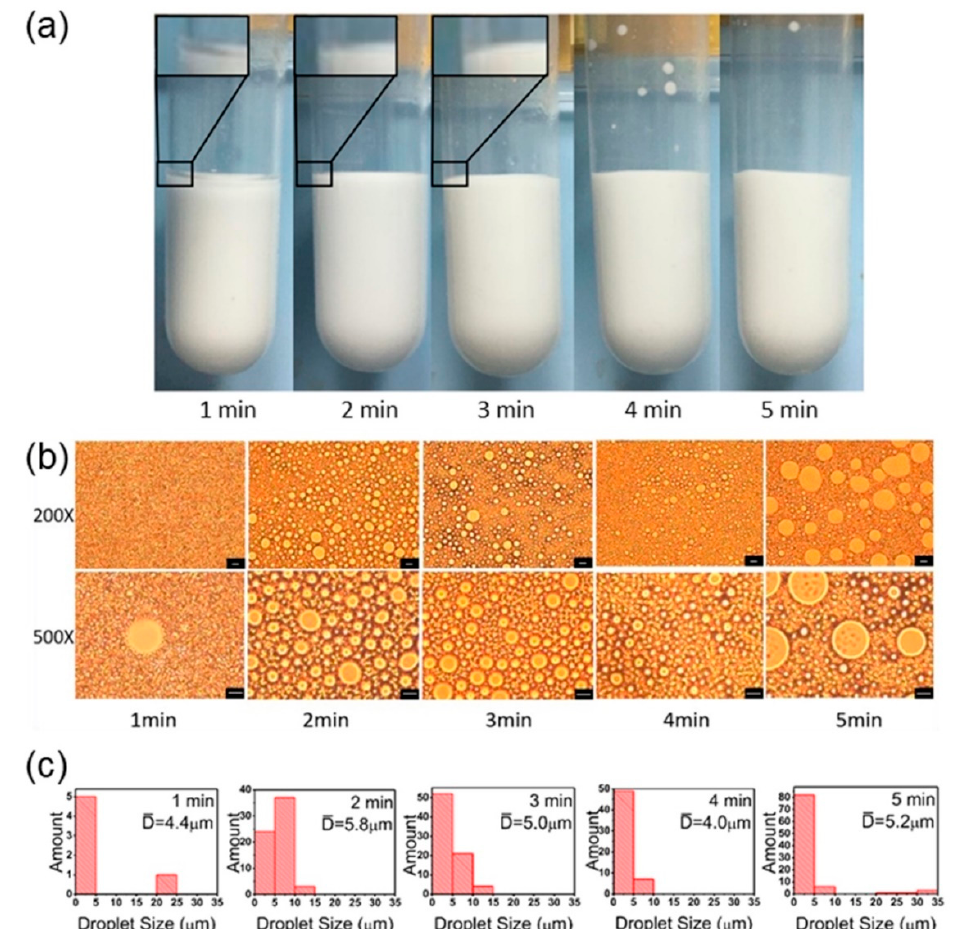
Figure 4. ( a ) Optical images of hexadecane / H 2 O Pickering emulsion stabilized by PS@PSS under di ff erent ultrasonic time. ( b ) Microscope images of hexadecane / H 2 O Pickering emulsion stabilized by